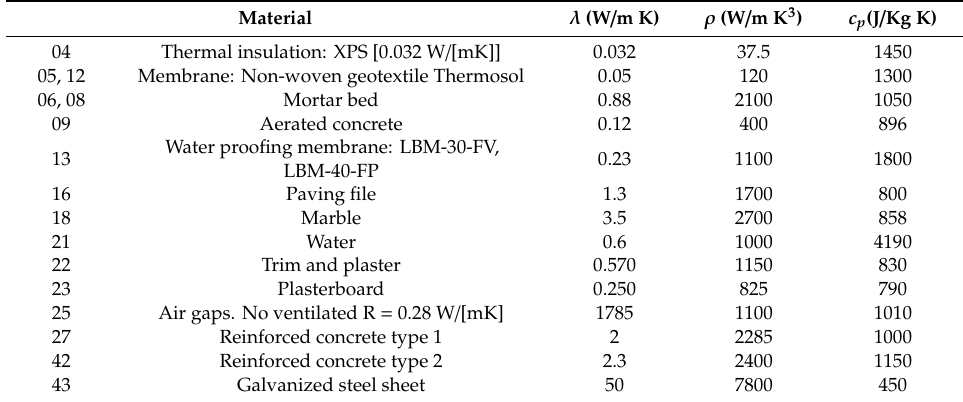
Table 7. Thermal properties of the materials that the roofs are built with thermal conductivity ( λ ), density ( ρ ) and specific heat capacity ( c p ).